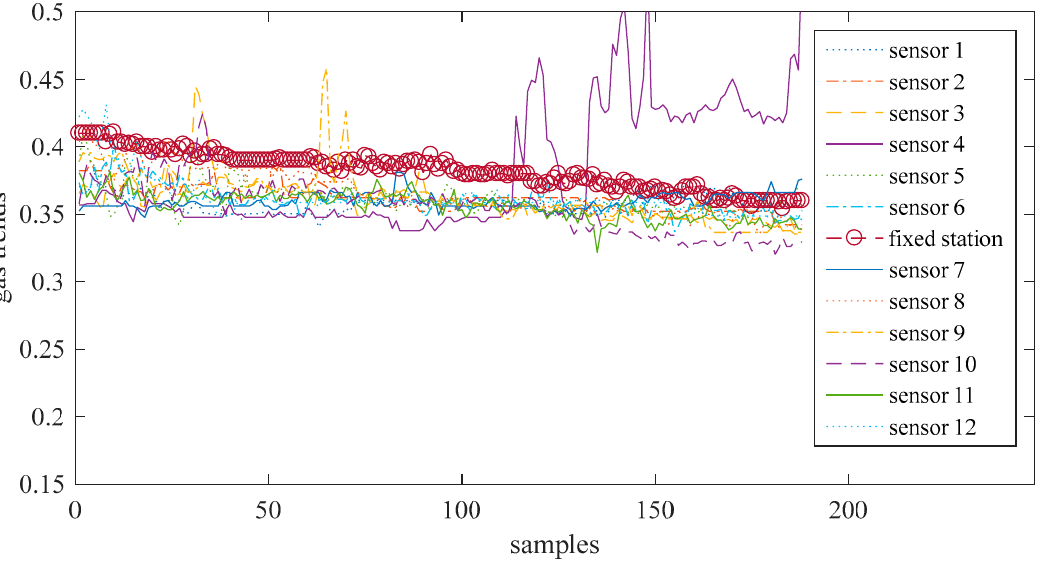
Figure 15. The calibrated 12 channel test gas signal and fixed gas signal.